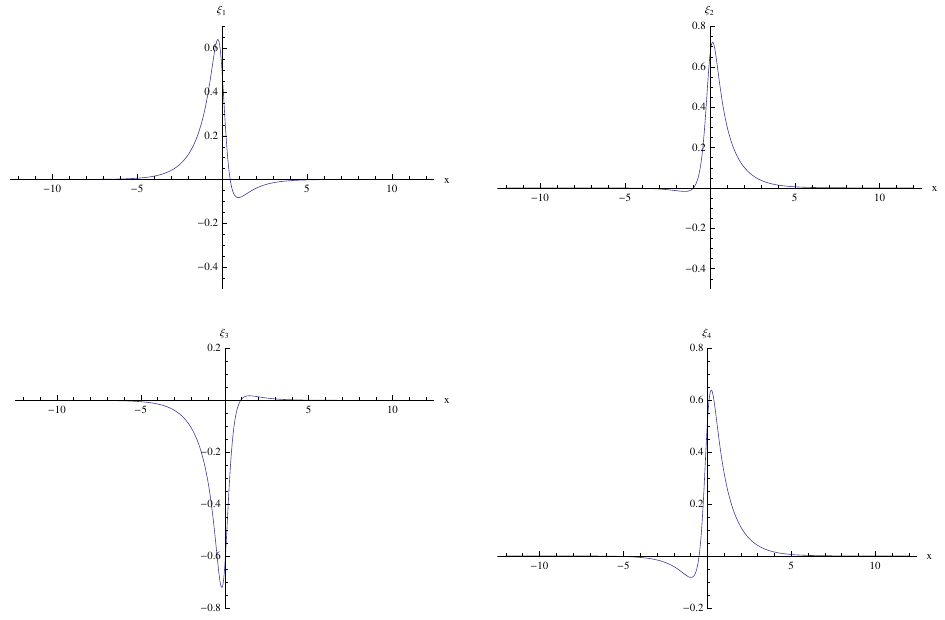
Figure 11 . The analytical bound state of the fermion as a function of x for the negative parity σ = − 1 . It is plotted for ρ 1 = 0 . 41 , ρ 2 = − 0 . 64 , θ 1 = 0 . 14 , θ 2 = 0 . 85 , κ = 1 , θ 0 = 2 π/ 3 . Notice the spinor components relationships ξ 1 ( − x ) = + ξ 4 ( x ) and ξ 2 ( − x ) = − ξ 3 ( x ) .